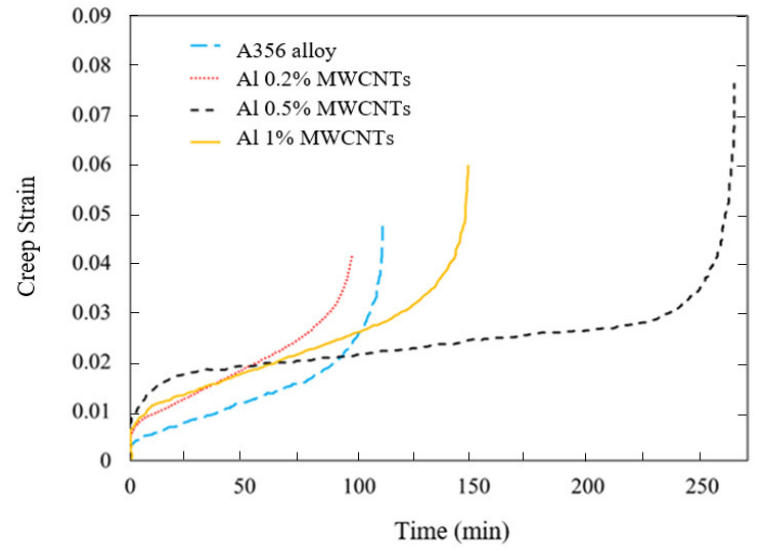
Figure 9. Creep strain diagram in time for A356 aluminum alloy and uncoated nanocomposites made with 0.2%, 0.5%, and 1% MWCNTs.